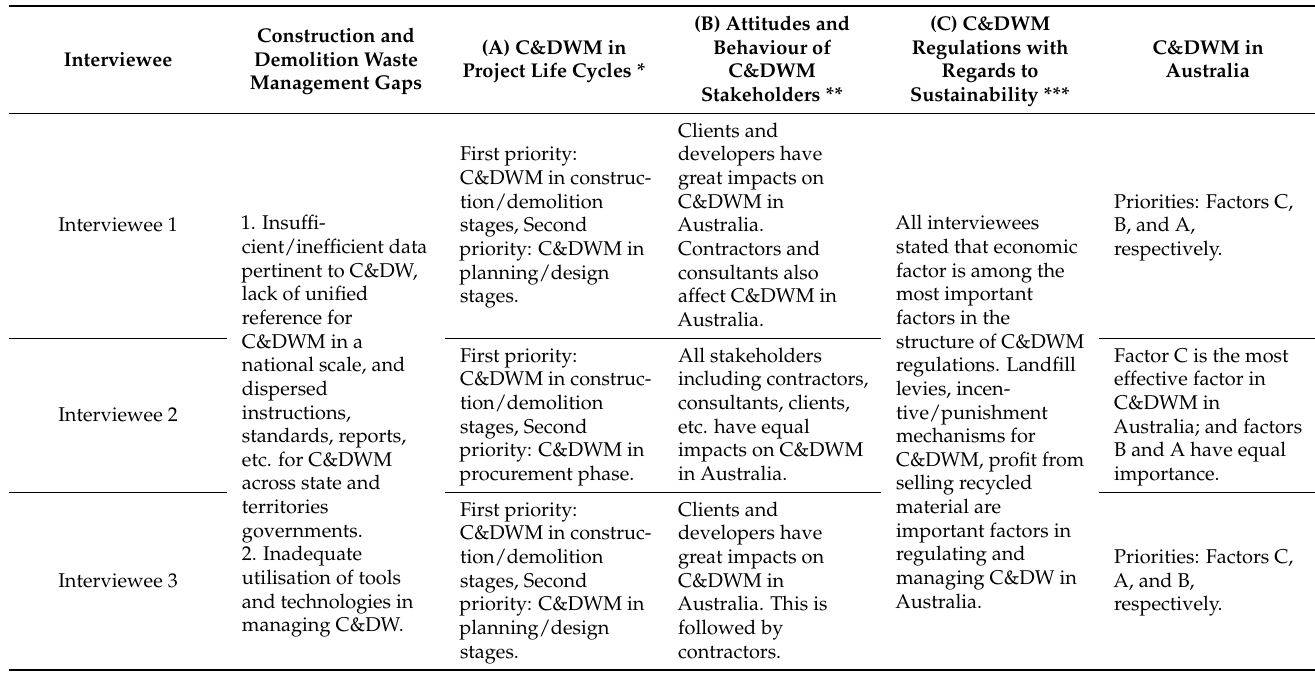
Table 4. Main findings of interviews with three C&DWM